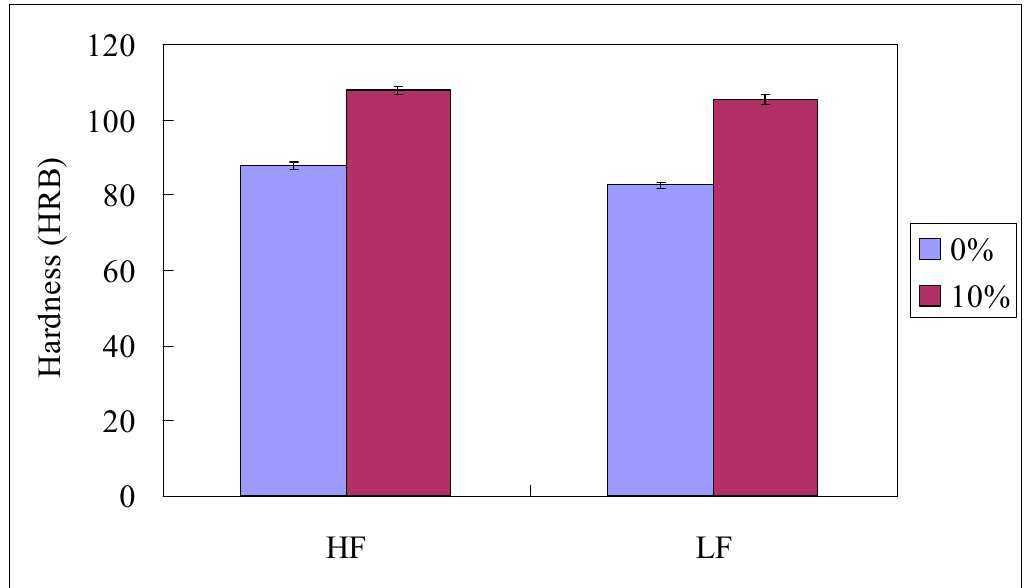
Figure 10. The hardness values with 10% deformation for HF and LF samples.